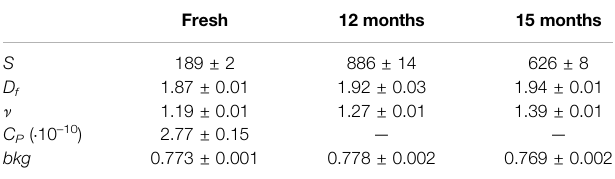
TABLE 2 | Best fi tting parameters obtained from SANS analysis by using Eq. 6 with